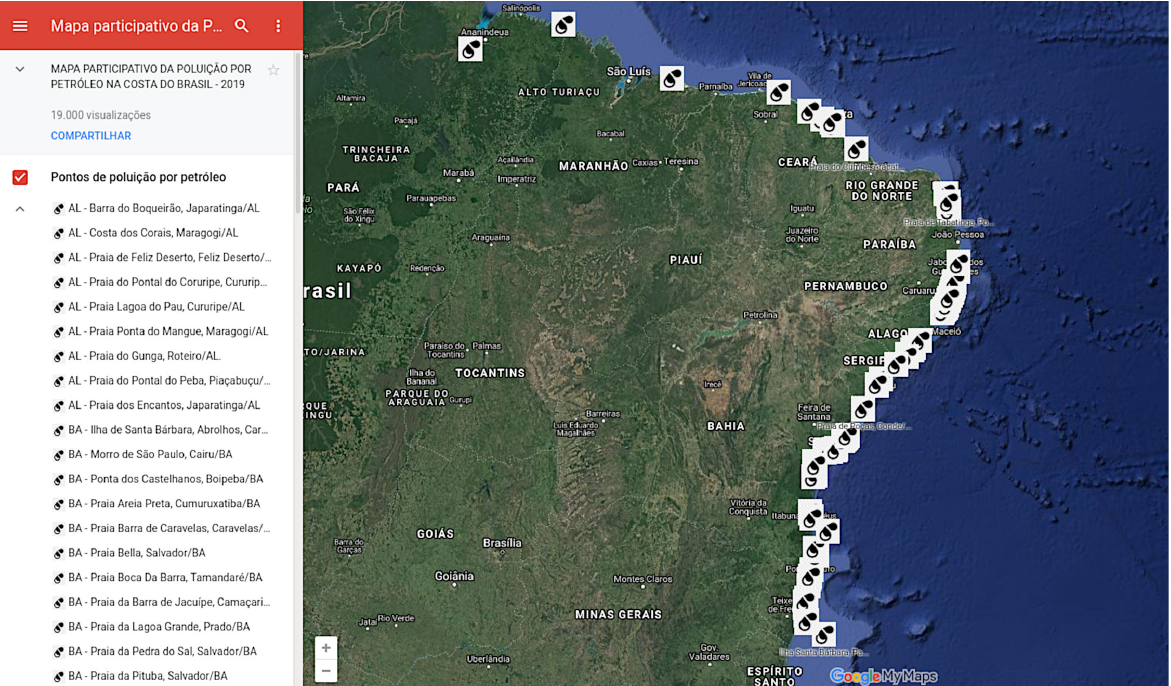
Figure 1. Participatory map of oil pollution – Brazil – 2019 - 2020. Available at: